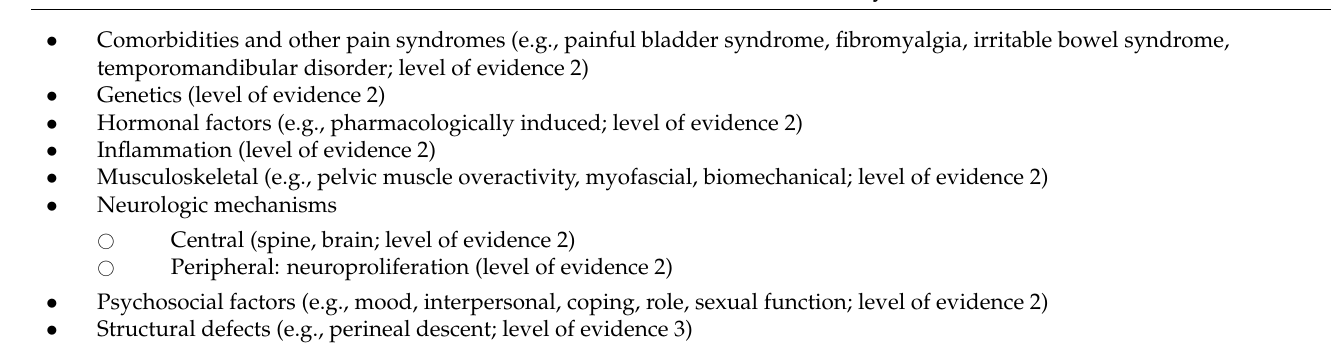
Table 2. 2015 ISSVD, ISSWSH, and IPPS Consensus Terminology and Classification of Persistent Vulvar Pain and Vulvodynia Vulvodynia—Potential Associated Factors